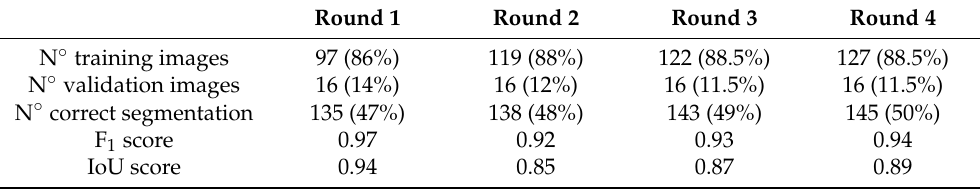
Table 4. Results obtained by the MobileNet-v2 U-Net model in the ASSL training strategy on the PetWound dataset. For each round, we reported the number of images used for the training and validation of the model, the number of correctly annotated images, and the segmentation metric scores. We considered as Round 0 the one performed with the model trained only on the Deepskin